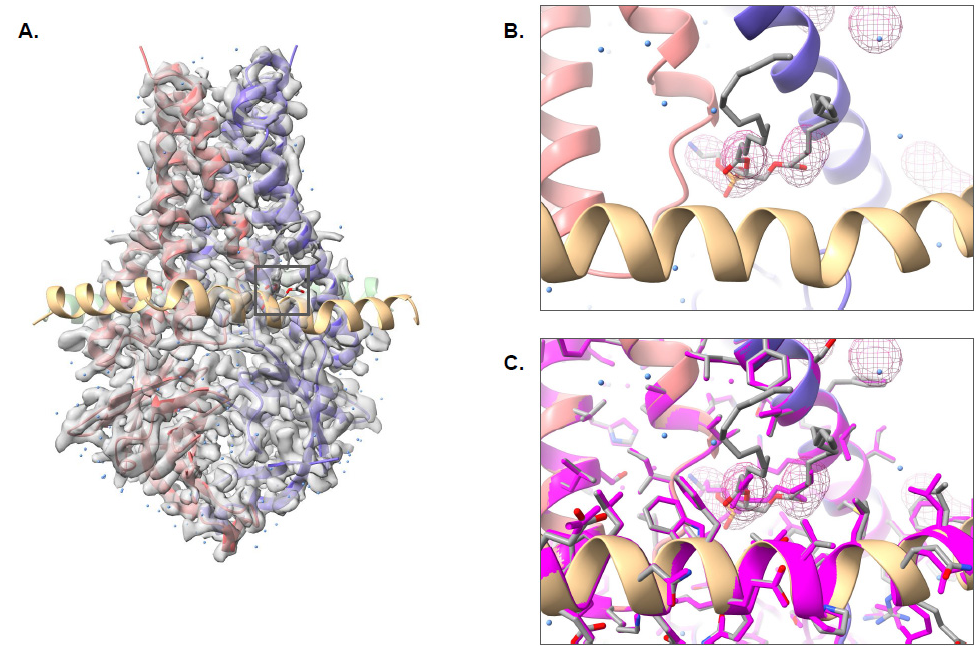
Figure 5. Pathwalking and ligand identification: EMD-22898. The complete Pathwalking model for SARS-CoV-2 ORF3a putative ion channel in nanodisc, including waters (blue) and ligands (gray) is shown in ( A ). A zoomed-in view of the identified ligand location, marked by a square in ( A ), by pw_ligands.py is shown as a cage in ( B ). The fitted and refined ligand, along with the water (blue) and protein models (colored by chain) are shown as well. In ( C ), the published model (magenta) is shown superimposed on the Pathwalking model.